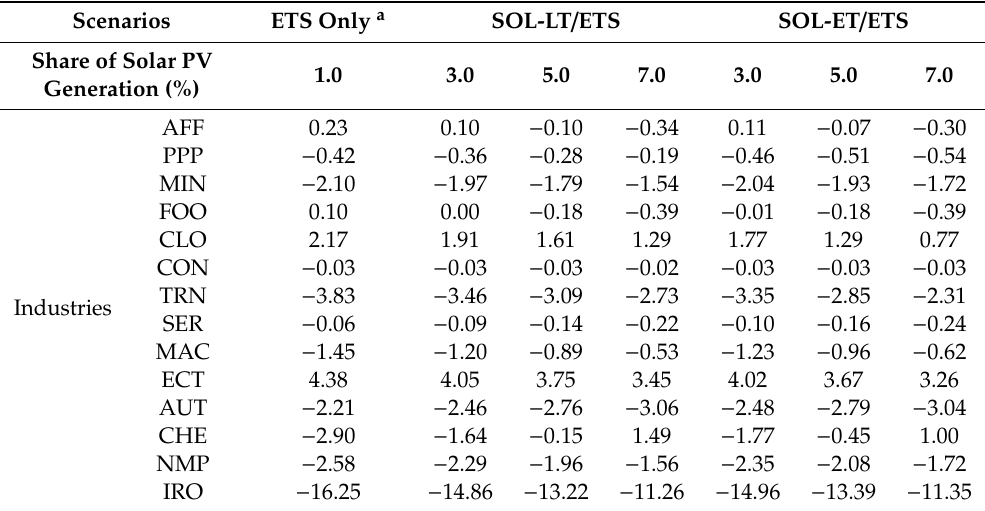
Table 14. Changes in output by industry according to the increase in the share of solar pv generation with emission regulations (% changes in output from the base year).